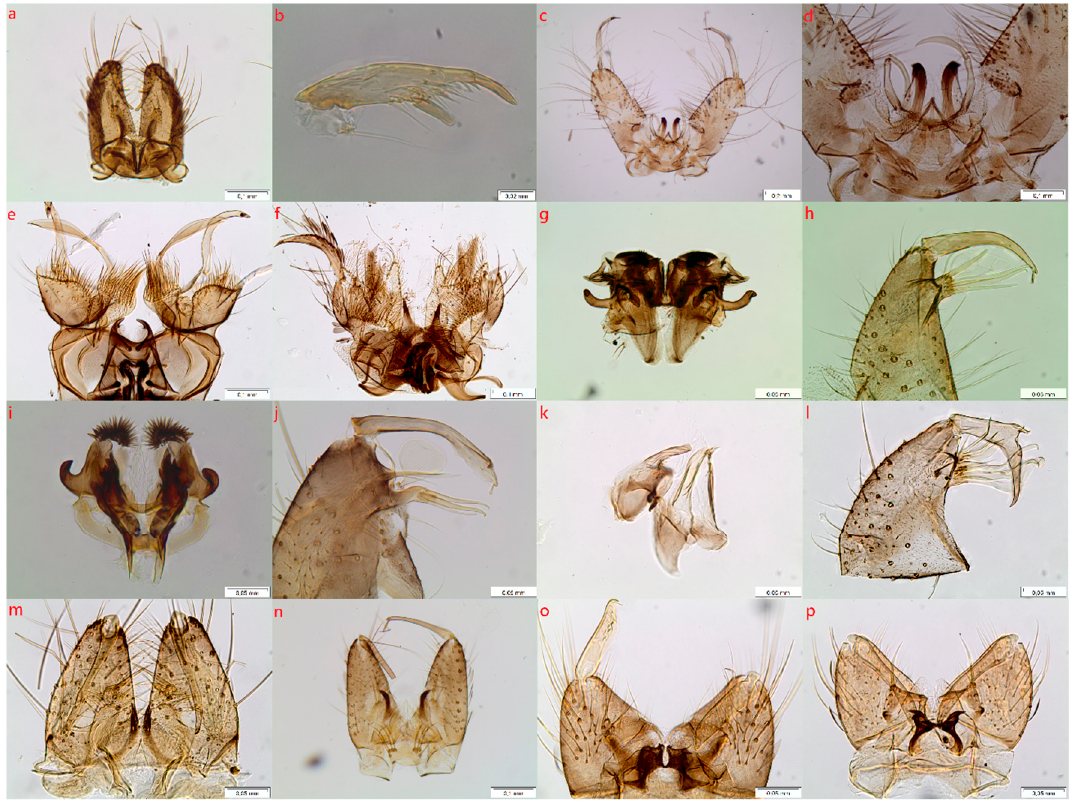
Figure 1. Genitalia of male mosquito species whose partial sequence of the CoxI gene was obtained for the first time in this study: ( a , b ) Ae . ( Alb .) capensis, ( c , d ) Ae . ( Muc .) mucidus , ( e ) Er. subsimplicipes , ( f ) Er. quinquevittatus , ( g , h ) Cx . ( Cux .) andersoni , ( i , j ) Cx . ( Cux .) telesilla , ( k , l ) Cx . ( Eum .) inconspicuosus , ( m ) Fi. uniformis , ( n ) Mi. hispida , ( o ) Ur . ( Ura .) alboabdominalis , ( p ) Ur. ( Pfc .) mashonaensis . Most photographs represent the whole genitalia, with the exception of ( b ) detail of gonostylus, ( d ) detail of basal dorsomesal lobe, claspettes, and proteger, ( g , i , k ) phallosome, and ( h , j , l ) gonocoxite with gonostylus.